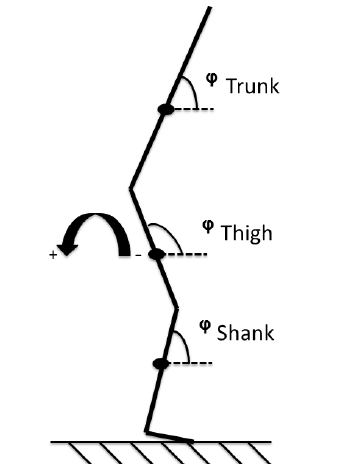
Figure 1. Convention used to define shank, thigh and trunk segmental angles